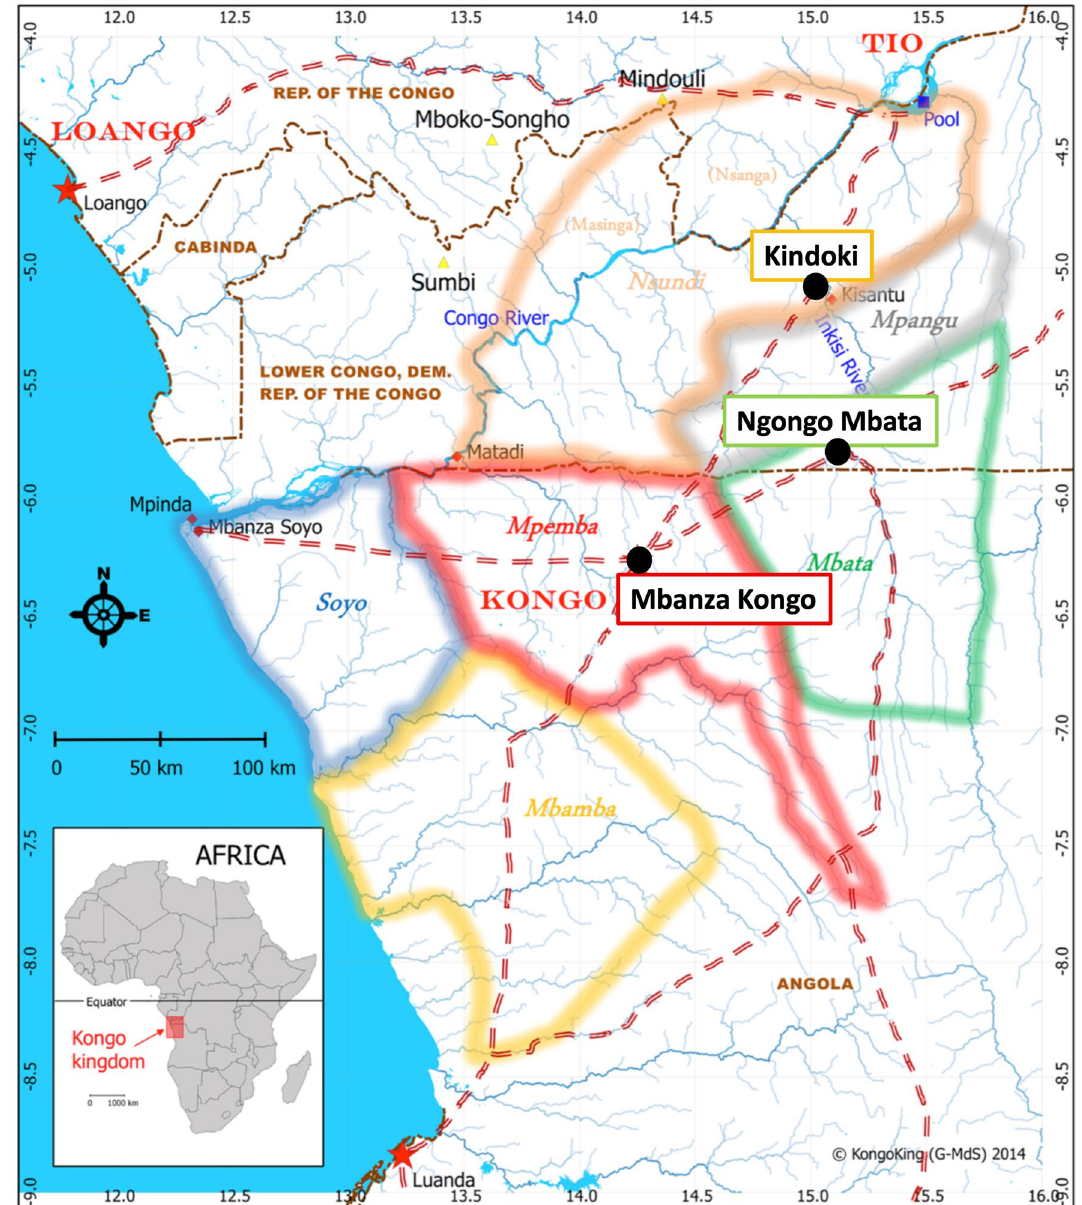
Figure 1. The Kongo kingdom and its six main provinces (Mpemba, Nsundi, Mbata, Soyo, Mbamba, Mpangu) in the Sixteenth to seventeenth centuries. The three sites (Mbanza Kongo, Kindoki and Ngongo Mbata) discussed in this study are shown on the